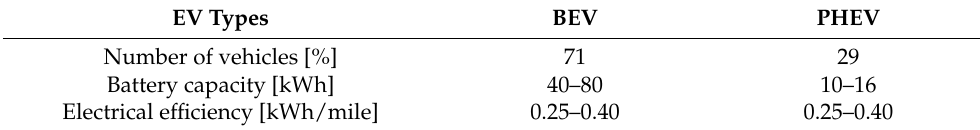
Table 3. Parameters of BMM